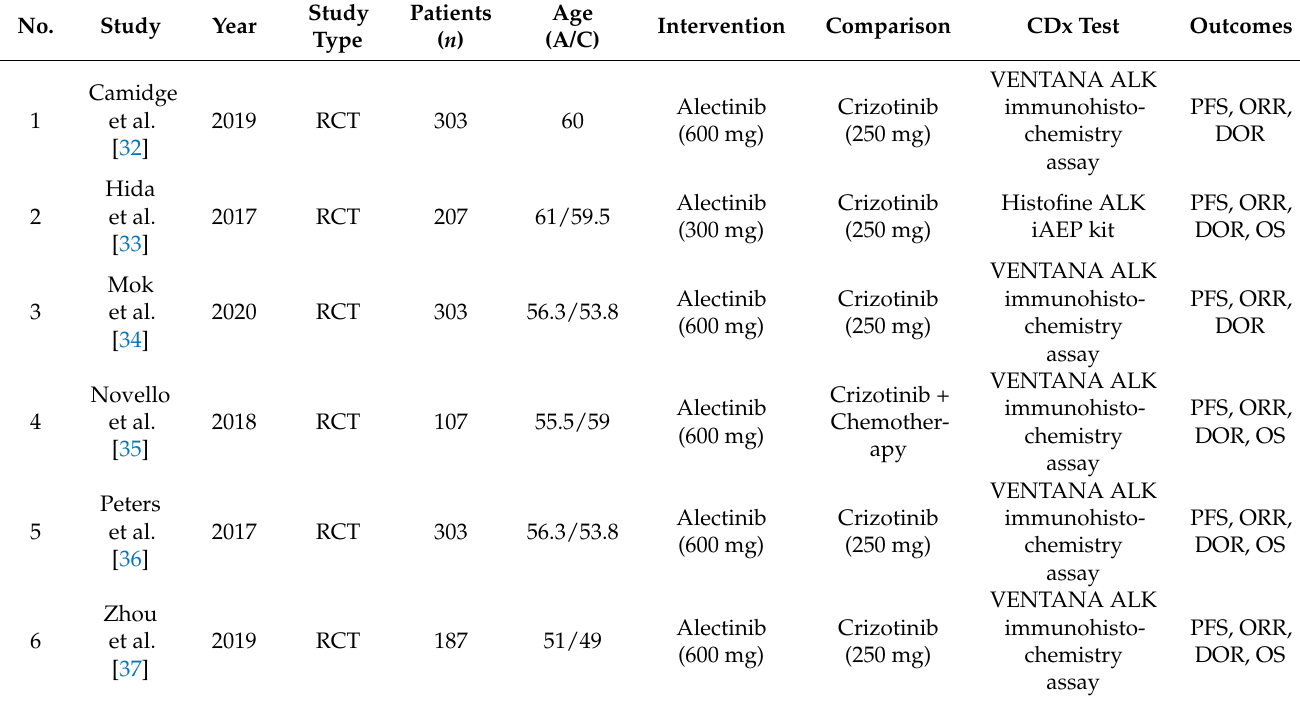
Table 2. Characteristics of included studies.